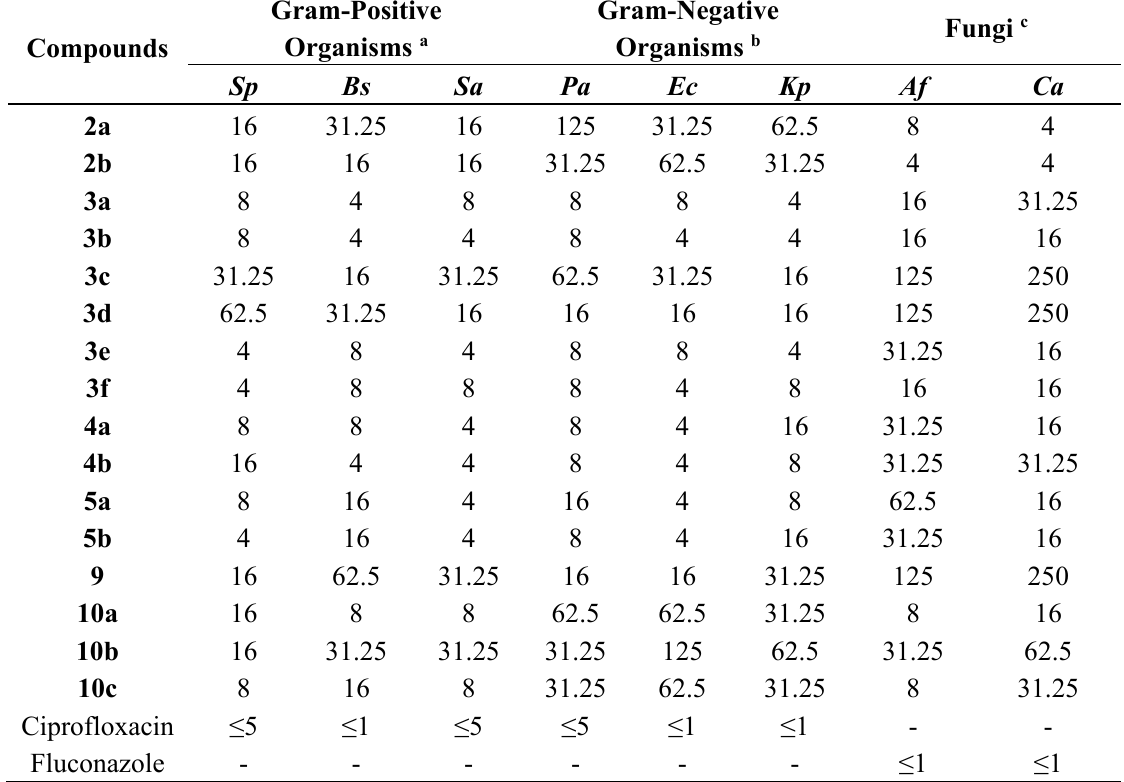
Table 1. Antimicrobial activity expressed as MIC ( μ